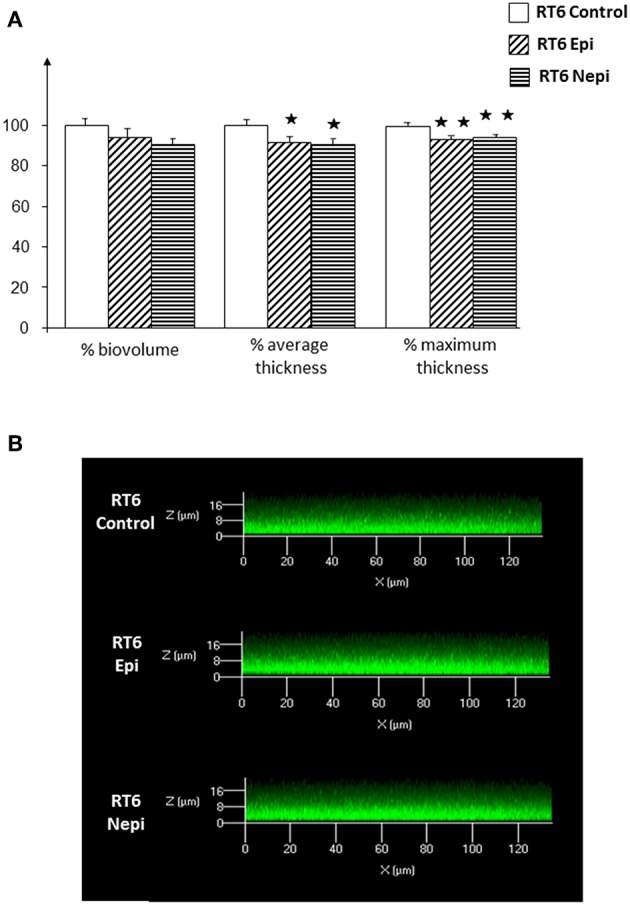
Effect of epinephrine and norepinephrine on biofilm formation by the RT6 non-acneic strain of Cutibacterium acnes on a glass support measured by confocal laser scanning microscopy. (A) Biovolume, average thickness, and maximum thickness of the biofilms after exposure to epinephrine (Epi) or norepinephrine (Nepi) calculated using Zen® 2009 software. (B) Representative views of X/Z sections of the biofilms formed in the presence or absence of epinephrine (Epi) or norepinephrine (Nepi). (⋆p < 0.05, ⋆⋆p < 0.01).